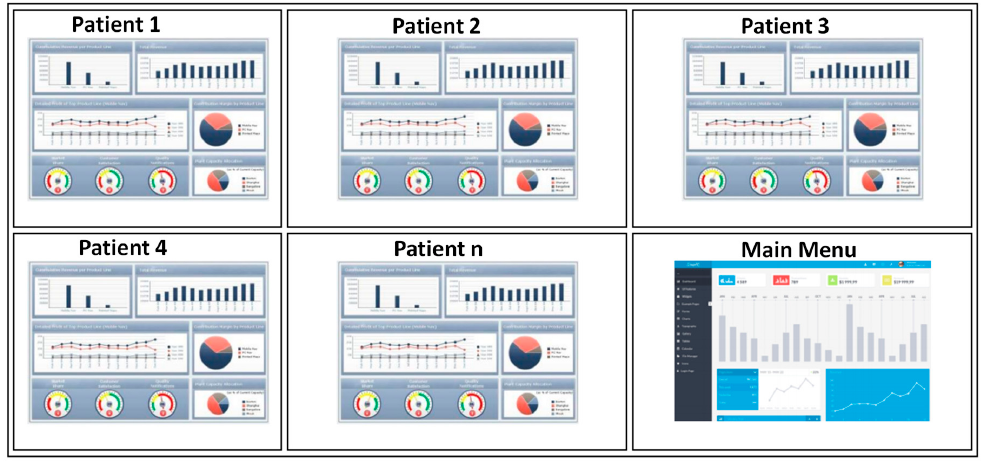
Figure 13. Example of monitoring different patient data.